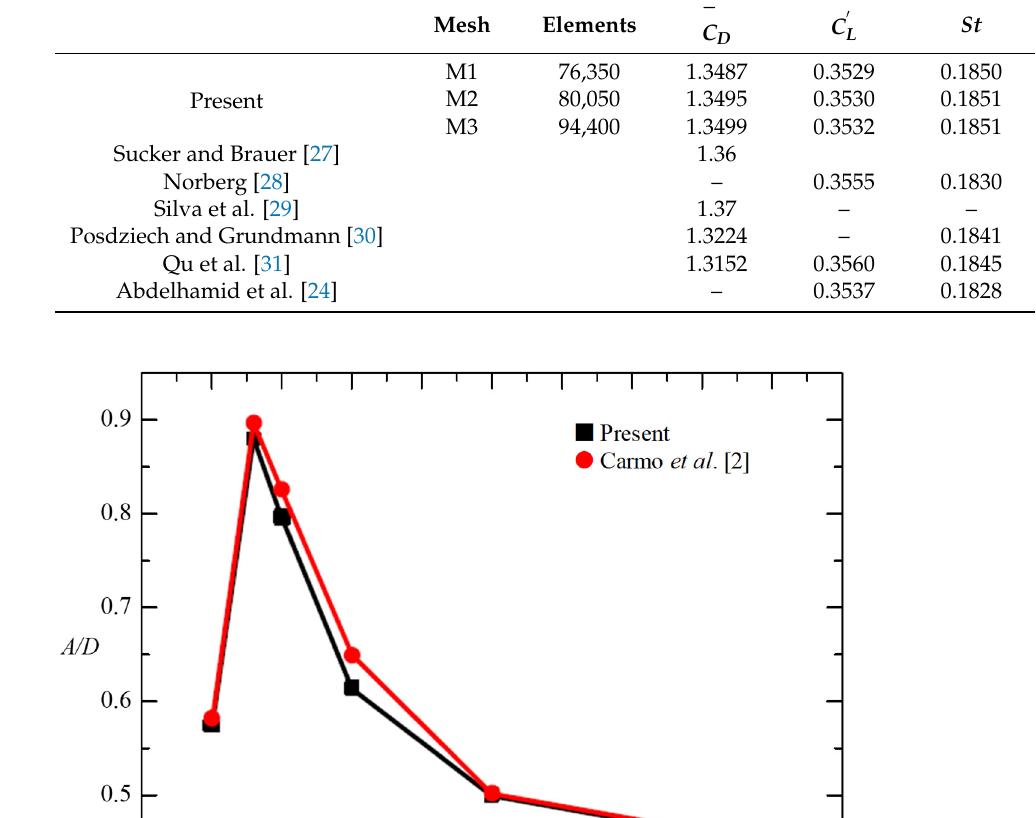
Table 1. Mesh independence test results for a single fixed cylinder at Re = 150 .